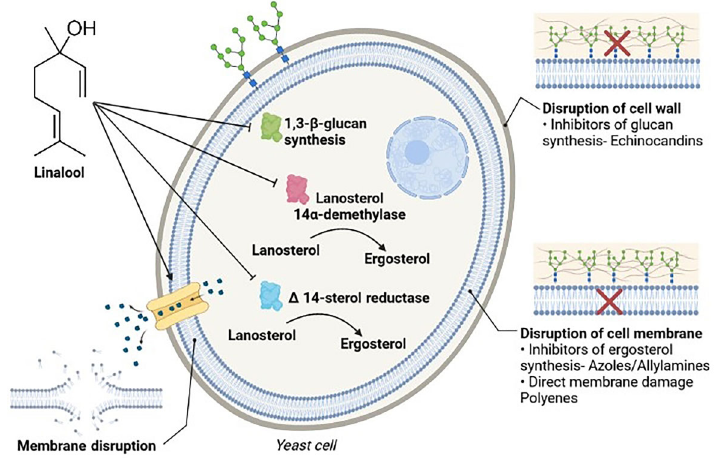
Figure 7. Summary representation of the predictive mechanism of action of linalool against four molecular targets of C. albicans strains based on in vitro test results and molecular docking. The linalool molecule appears to interfere with fungal cell wall maintenance involving 1,3- b -glucan synthase. Linalool can also interfere with fungal cell membrane integrity, altering the ergosterol content of these cells through interactions with lanosterol 14 a -demethylase, D 14-sterol reductase, and/or formation of permeability pores and consequent lysis of the fungal cell